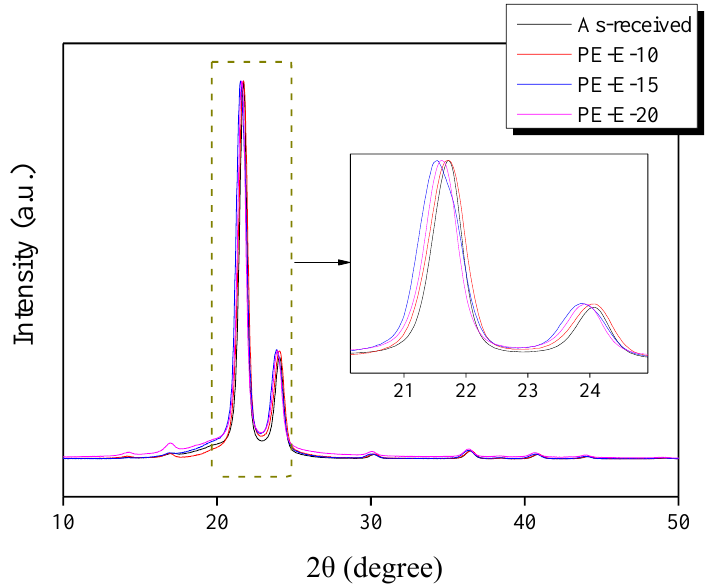
Figure 3. X-ray diffraction (XRD) patterns of as-received LLDPE fibers and E-beam crosslinked LLDPE fibers. Table 2. XRD result of as-received LLDPE fibers and E-beam-treated fibers.